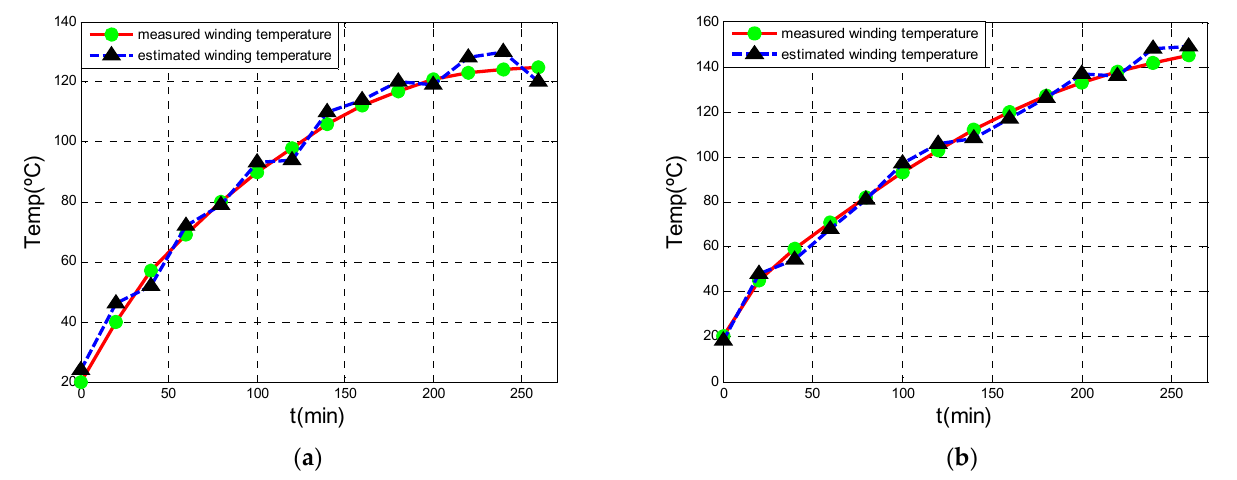
Figure 9. Stator winding temperature estimation for two operation points being the stator frequency equal to 30 Hz. ( a ) At nominal torque. ( b ) At 120% of nominal torque.